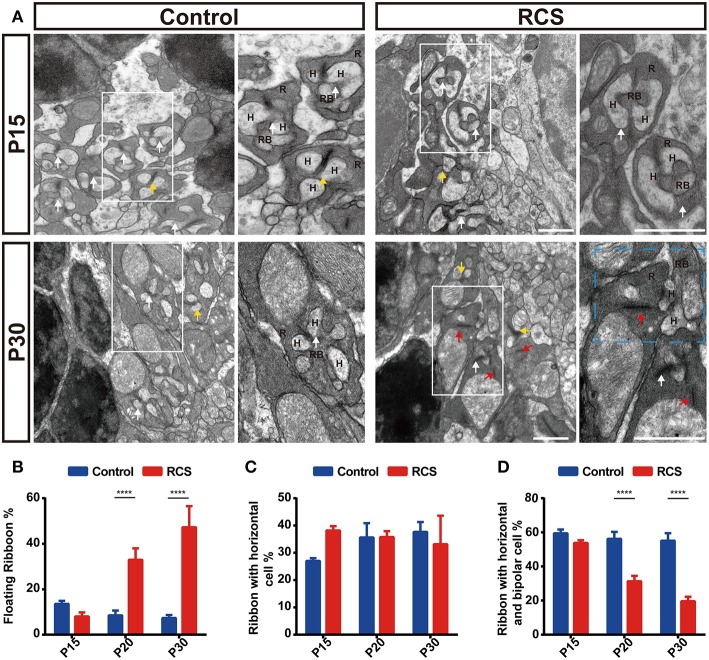
The ultrastructure of rods in ON-RBC synapses in the OPL is disrupted during retinal degeneration in RCS rats. (A) Synaptic ultrastructure in the OPL of control and RCS retinas as revealed by transmission electron microscopy at P15 and P30. The cyan rectangle indicates a perturbation of postsynaptic cell dendrite invagination into the photoreceptor terminus. White arrows indicate normal rod synapses, called triads, with three postsynaptic elements (the ribbon was a presynaptic specialization; the three postsynaptic elements invaginated into the base of the photoreceptor such that two horizontal cell and one bipolar cell dendrite are located centrally), red arrows indicate floating ribbons, yellow arrows indicate dyads with only one or two horizontal cell processes opposed to the ribbon. (B) Proportion of floating ribbons in control and RCS rats at P15, P20, and P30, indicating that disruption of rod synapse correlated with rod cell stress (N = 3 eyes from different rats, n = 8–12 images from each eye). (C) A difference in the proportion of dyads in RCS rats compared to controls was not observed at P15, P20, and P30 (N = 3 eyes from different rats, n = 8–12 images from each eye). (D) The proportion of normal synapses was significantly decreased during retinal degeneration (N = 3 eyes from different rats, n = 8–12 images from each eye). R, rod cell; RBC, rod bipolar cell; H, horizontal cell. Scale bar, 1 μm (A). Bars represent means; error bars represent SD. ****p < 0.0001 using two-way ANOVA (B–D).